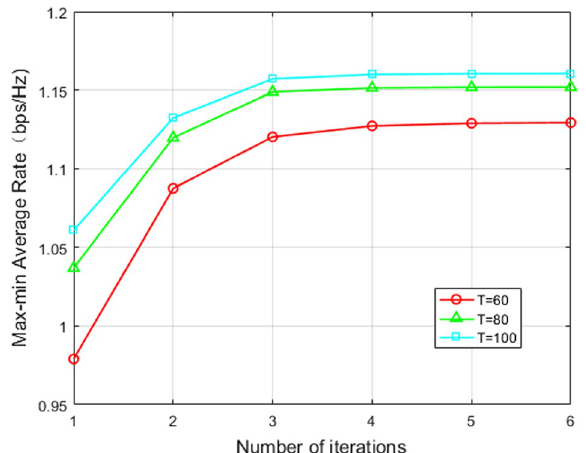
Fig. 7 Convergence of proposed